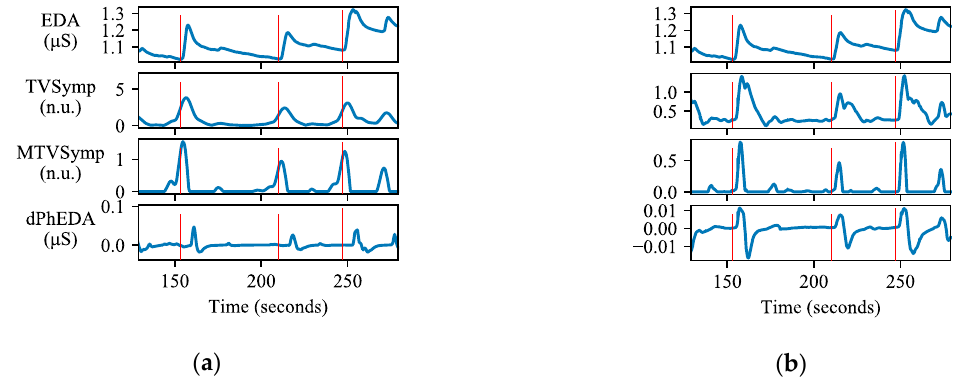
Figure 4. An example of EDA signal and derived time series: ( a ) EDA indices calculated using the entire recording, ( b ) EDA indices calculated using our objective real-time pain measuring scheme based on windowing. Red bars indicate where stimuli were given.